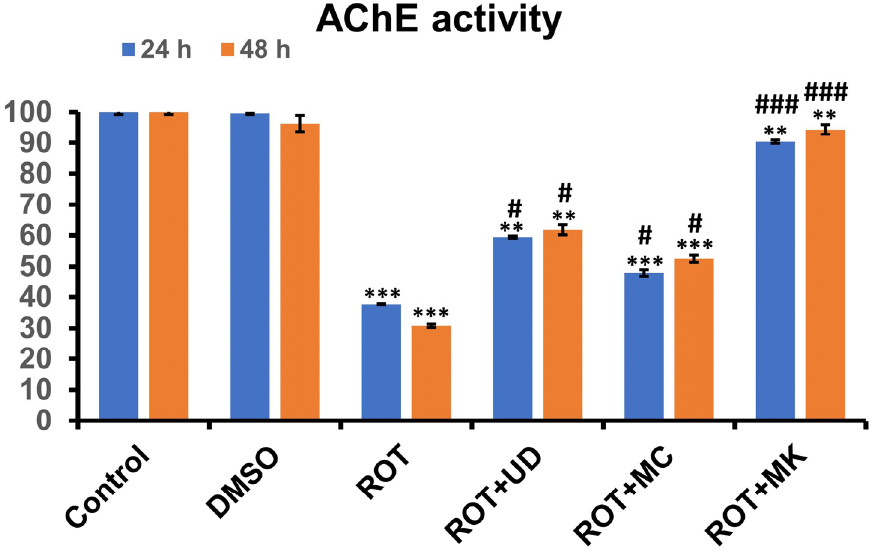
Figure 8. Acetylcholinesterase activity in the third instar larvae of D. melanogaster (Oregon R + ) exposed to 500 µ M ROT alone or in combination with UD, MC, and MK for 24 and 48 h. Data represent mean ± SD (n = 3); significance ascribed as ** p < 0.01, *** p < 0.001 vs. control or DMSO control. # is ascribed as significance at p < 0.05, ### p < 0.001 as compared with 500 µM rotenone. UD= Urtica dioica, MC = Matricaria chamomilla and MK= Murraya koenigii .